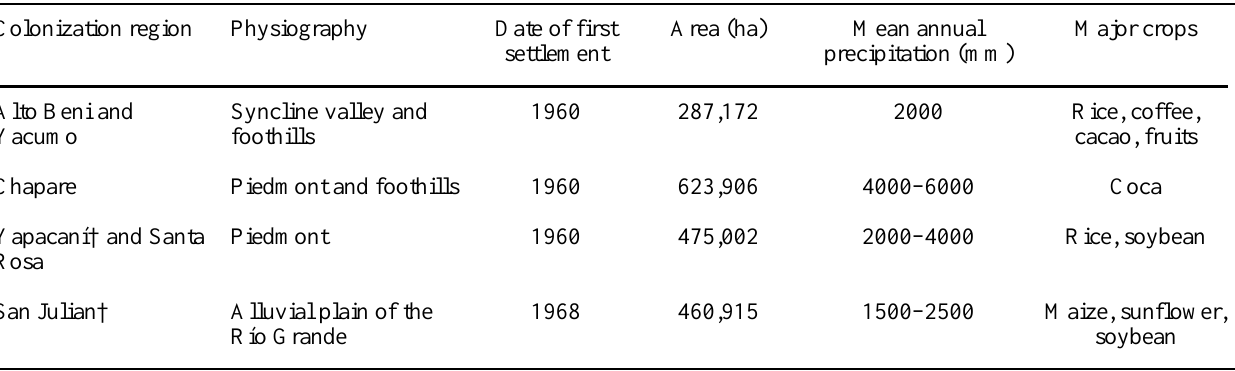
Table 3. Regional variation in the environment and production systems in four different regions settled by Andean indigenous